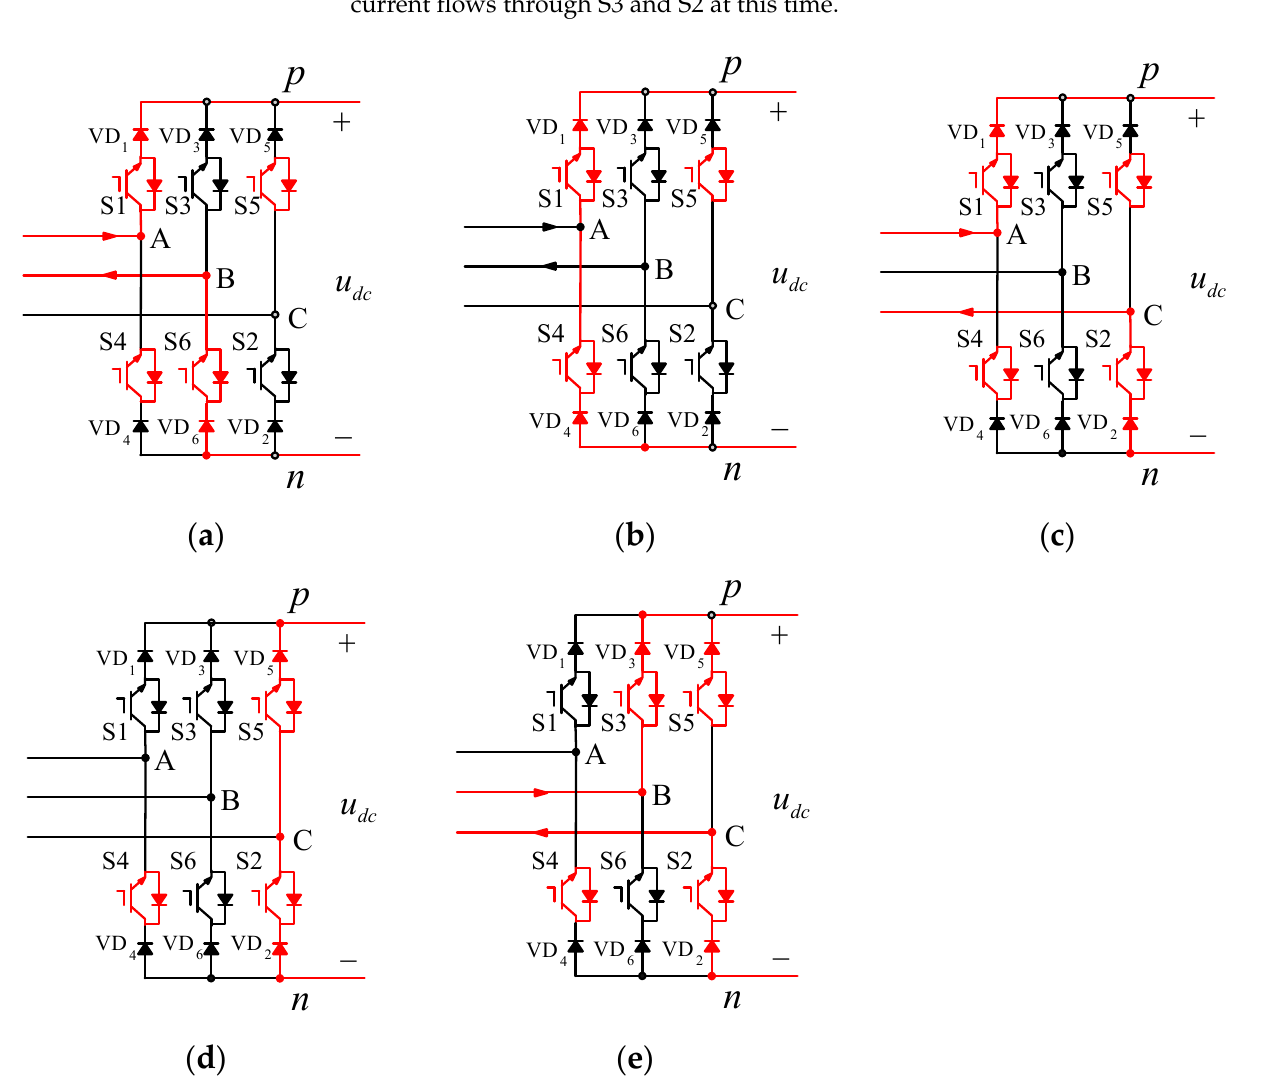
Figure 7. Switching process diagram. ( a ) S1, S6 are effectively turned on. ( b ) S6 switches to S2. ( c ) S1, S2 are effectively turned on. ( d ) S1 switches to S3. ( e ) S2, S3 are effectively turned on.